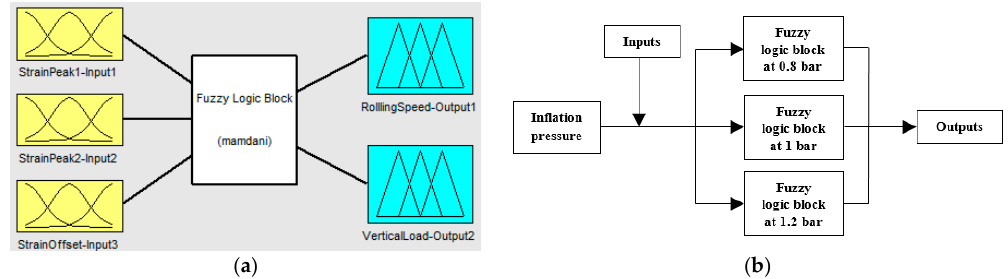
Figure 14. ( a ) Fuzzy Logic toolbar interface; ( b ) Working scheme used to obtain outputs.